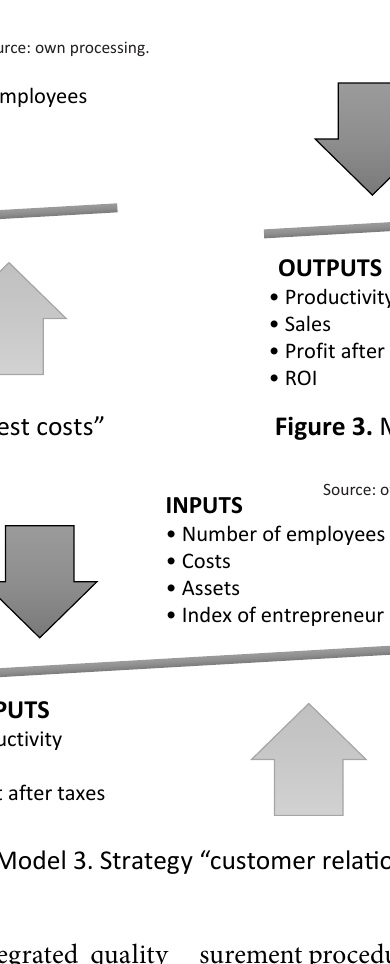
Table 3. Summary results of the regression analysis of the variables of each model